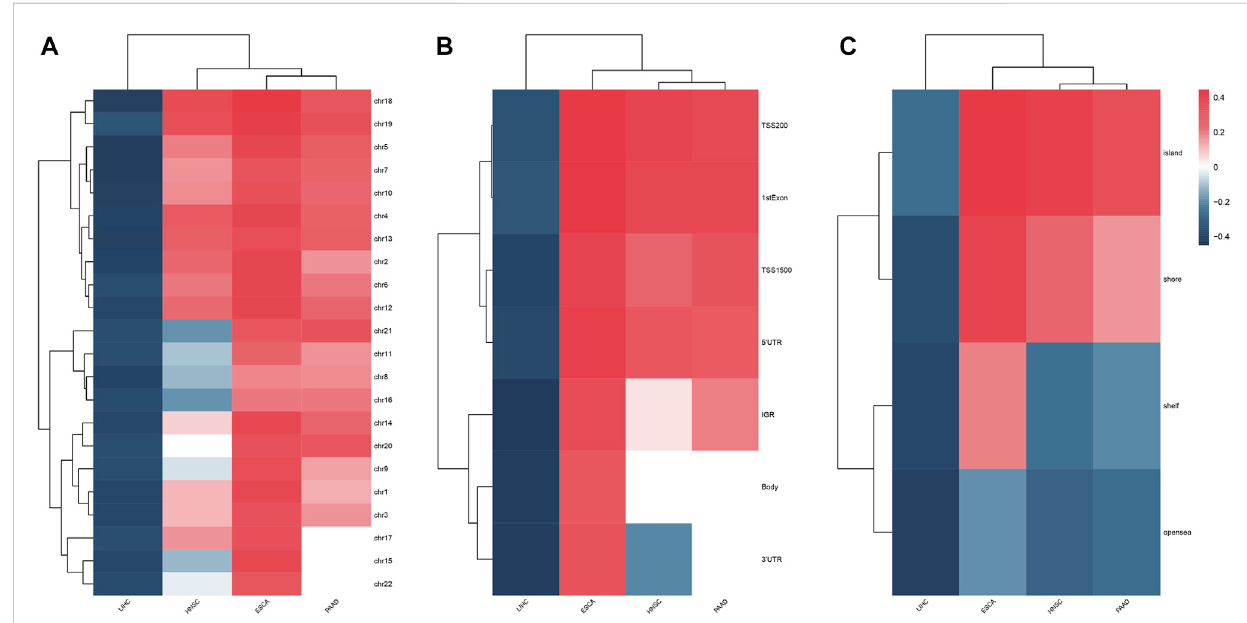
FIGURE 2 Heatmap showed the methylation status of chromosomes (A) , feature regions (B) , and CpG regions (C) in four alcohol-associated